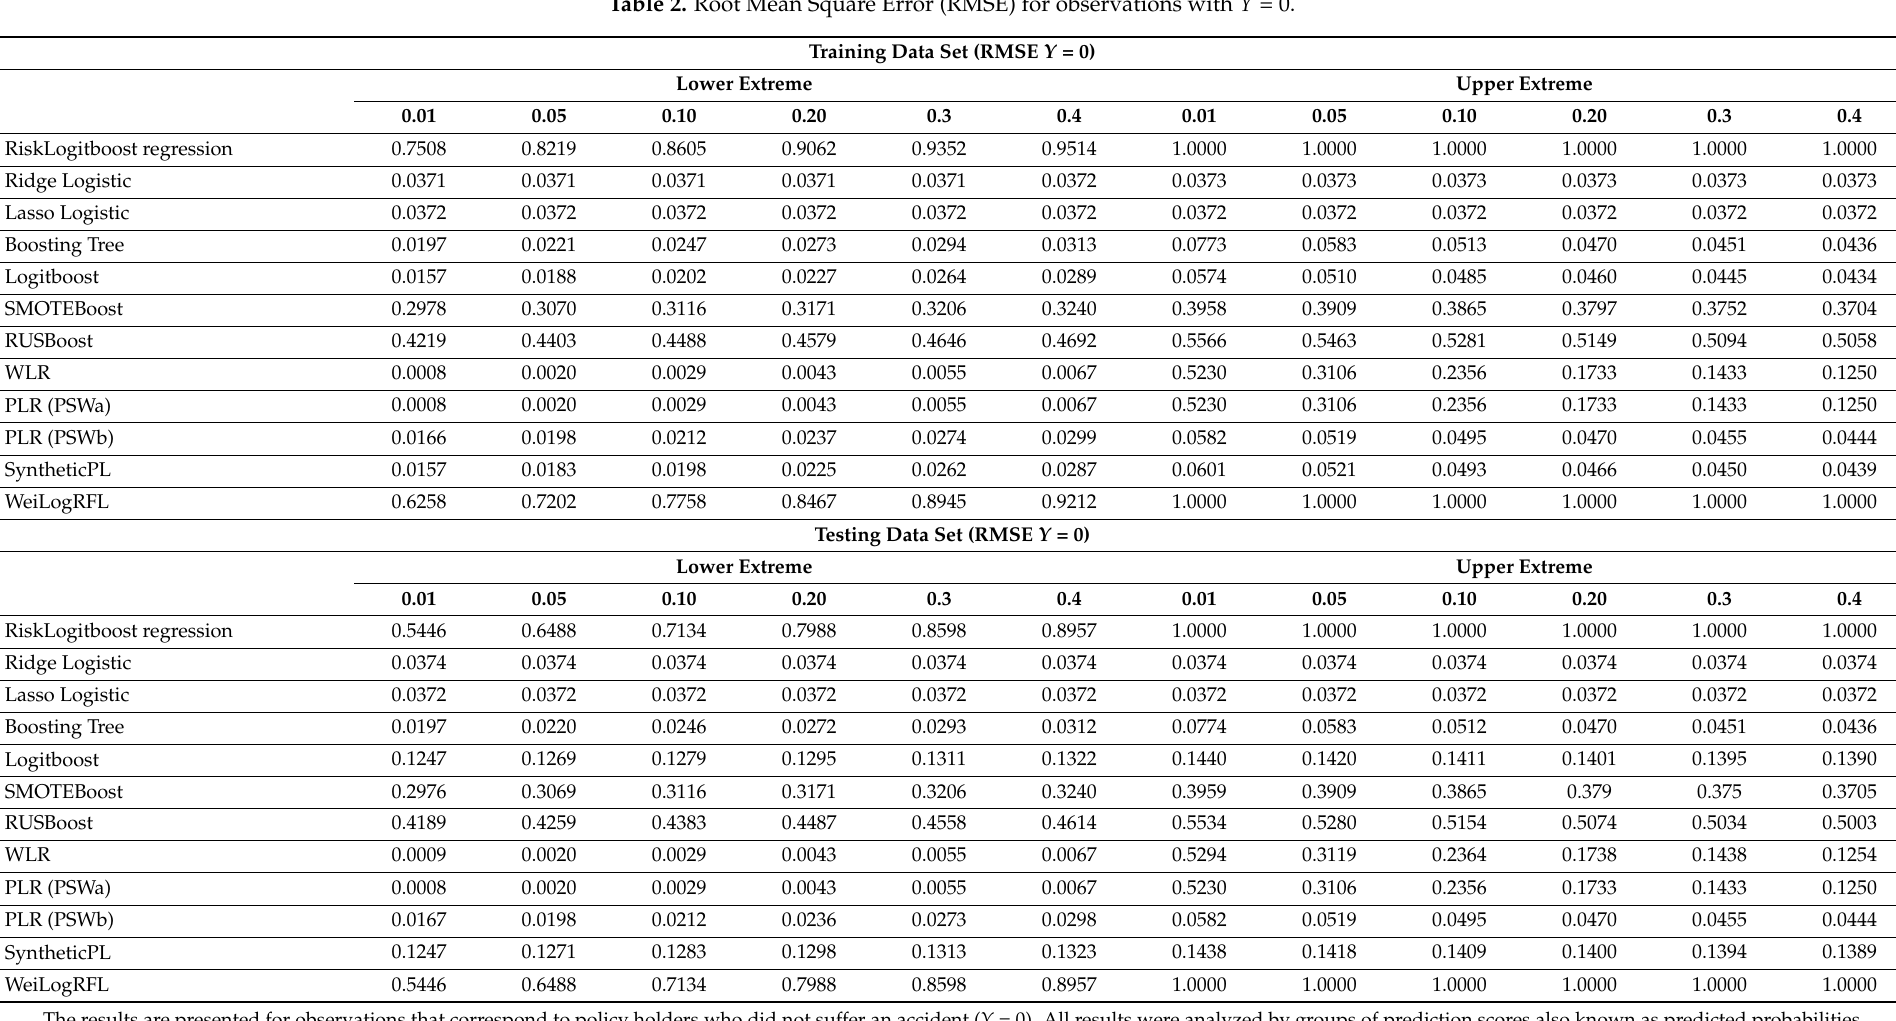
Table 2. Root Mean Square Error (RMSE) for observations with Y =